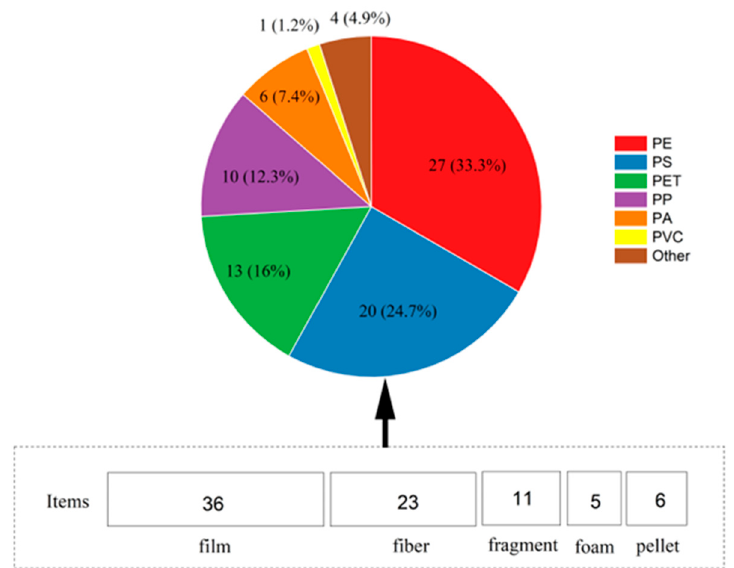
Figure 5. Microplastic polymers in 81 analysis samples by μ -Roman.